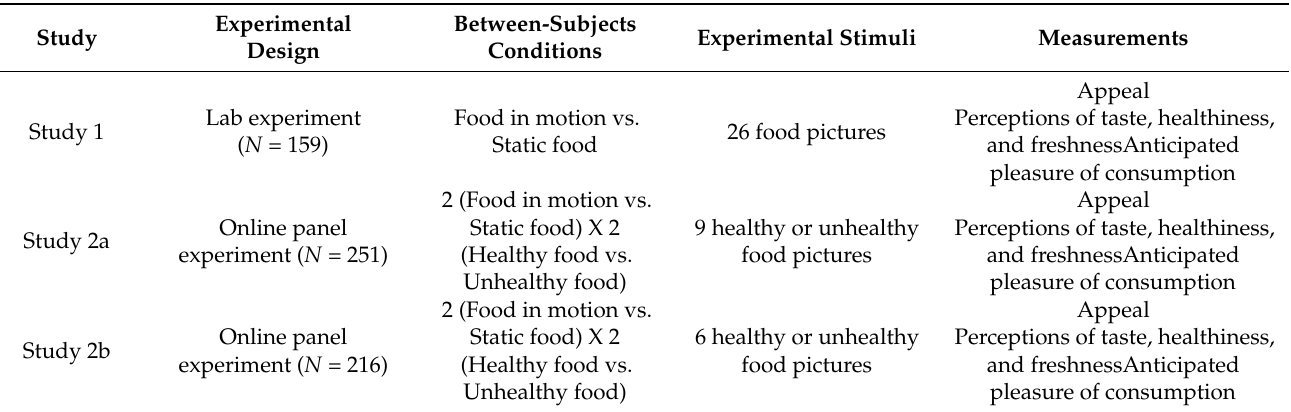
Table 1. Overview of experimental